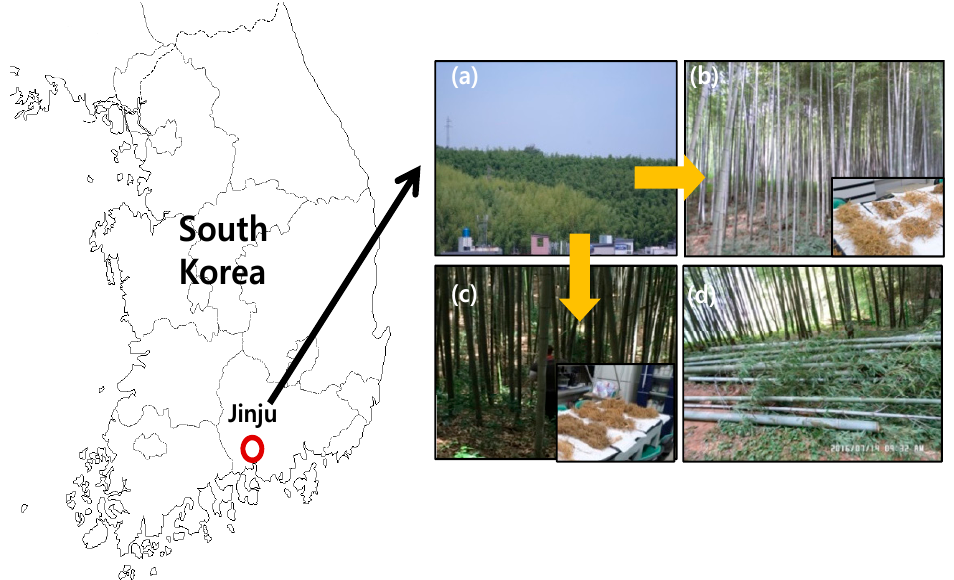
Figure 1. Dark green color of leaves in fertilized sites and light green color of leaves in unfertilized sites ( a ) of a Moso bamboo ( Phllostachys pubescens ) stand in the Gajwa National Experimental Forest, Jinju, Korea. Bamboo roots and rhizomes of fertilized ( b ) and unfertilized ( c ) plots. Sampled bamboo from fertilized plots ( d ).